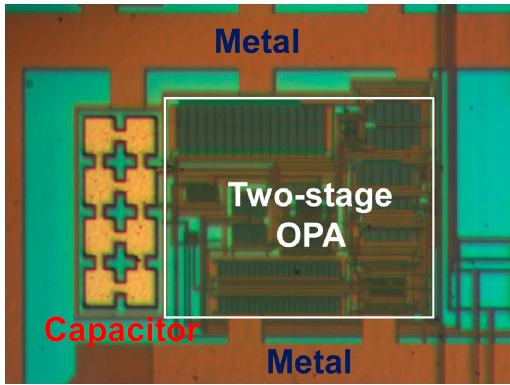
Figure 12. Microphotograph of the designed low-voltage two-stage cascaded opamp without external resistors and capacitors.